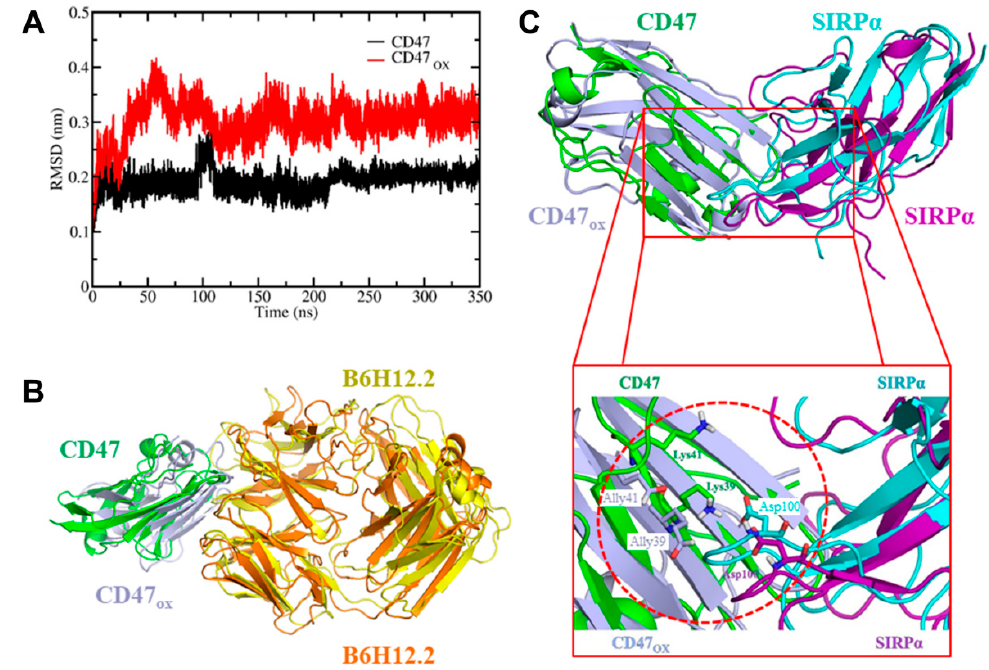
Figure 4. In silico evaluation of the mechanisms of NTP action on immunosuppressive CD47. ( A ) Root mean square deviation (RMSD) of the backbone atoms of the native CD47 and oxidized CD47 (CD47 OX ) structures. ( B ) Cartoon view of aligned native (green and cyan) and oxidized (light blue and purple) CD47–SIRP α systems. Lysine (Lys) is modified into allysine (Ally) after oxidation (Tables S1 and S2). ( C ) Salt bridges are formed between Lys39-Asp100 and Lys41-Asp100 in the native complex and broken after oxidation of CD47 (see circle in inset).